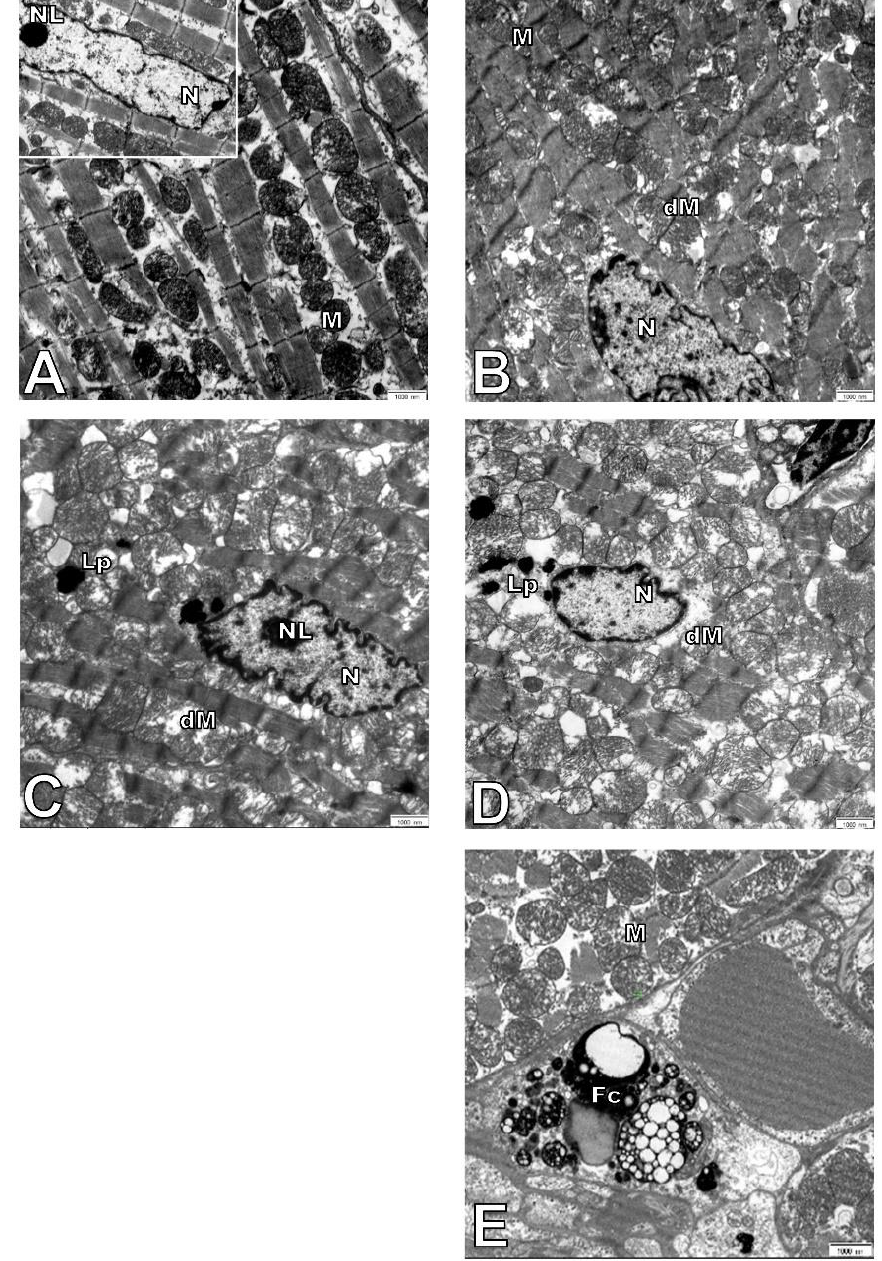
Figure 6. Electron micrographs showing ultrastructure of cardiomyocytes. The figure shows representative pictures of C57Bl/6J ( A ) and ApoE − / − ( B ) 7-month-old mice and C57Bl/6J ( C ) and ApoE − / − ( D , E ) 17-month-old mice. Fc—foam cell, Lp—lipofuscin, M—mitochondria, dM—damage mitochondria, N—nucleus, NL—nucleolus, V—vacuoles. Scale bar = 1000 nm.